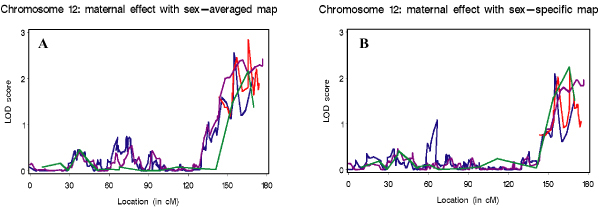
Multipoint linkage results for maternal effect on chromosome 12. (A) Results for maternal allele sharing using sex-averaged genetic map; (B) results for maternal allele sharing using sex-specific map. Colors: microsatellite markers (green), SNPs from Illumina (purple), SNPs from Affymetrix (blue), combination of 3 microsatellite markers, 19 SNPs from Illumina, and 28 SNPs from Affymetrix (red).